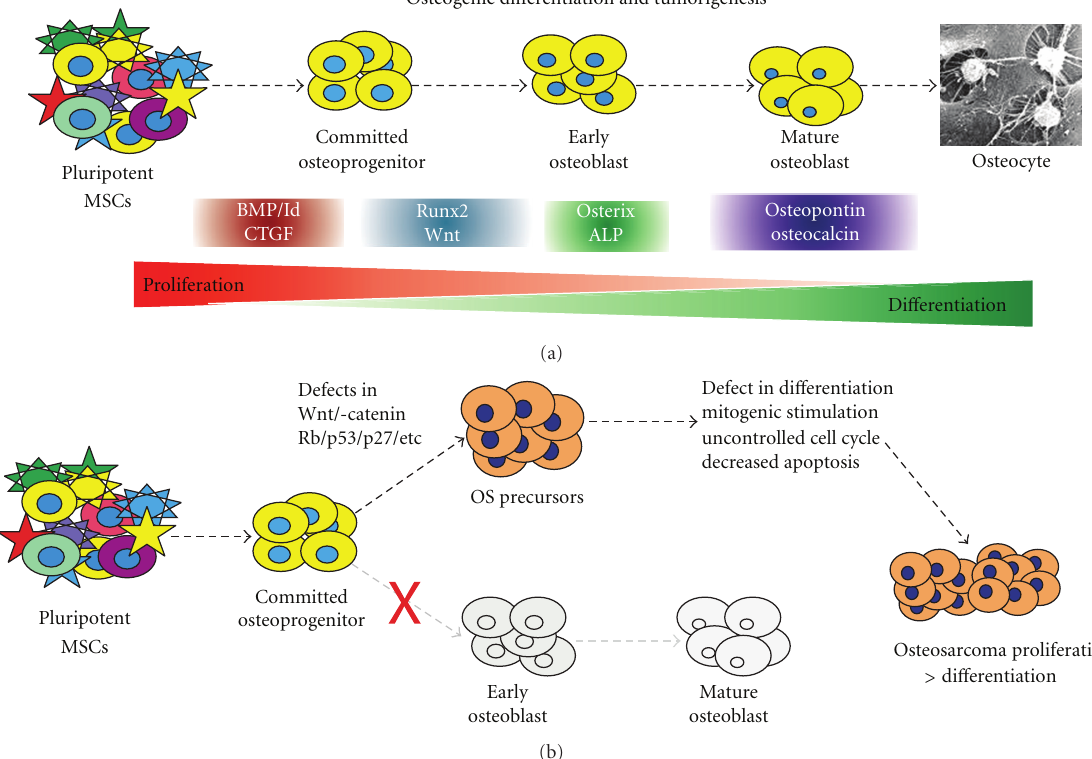
Figure 1: (a) Mesenchymal stem cells (MSCs) progress down the osteogenic di ff erentiation cascade. MSCs are pluripotent bone marrow stromal cells that are able to di ff erentiate into bone, muscle, tendon, and adipose tissue. Osteogenic di ff erentiation of MSCs is a tightly regulated process by di ff erent signaling. Bone morphogenetic proteins (BMPs) and their downstream mediators, such as inhibitor of DNA binding (Id) proteins and connective tissue growth factor (CTGF), are early markers in the osteogenic di ff erentiation cascade. Runx2 and Wnt proteins are important regulators of osteoblastic di ff erentiation. Alkaline phosphatase and Osterix are early/middle markers, while osteocalcin and osteopontin are late markers of bone formation. (b) Defects in osteogenic di ff erentiation lead to osteosarcoma (OS) development. If alterations in the MSC di ff erentiation cascade block the progression to terminally di ff erentiated osteoblasts or osteocytes, it is likely that tumorigenic precursors are formed. Such undi ff erentiated OS precursors would maintain the ability to proliferate and increase the risk for OS development. Although not well understood, some of the potential defects may include genetic and/or epigenetic changes in Wnt signaling, Rb, p53, and p27. These defects may lead to uncontrolled cell proliferation and disrupted di ff erentiation. Thus, these alterations disrupt the delicate balance between proliferation and di ff erentiation, leading to a tumorigenic